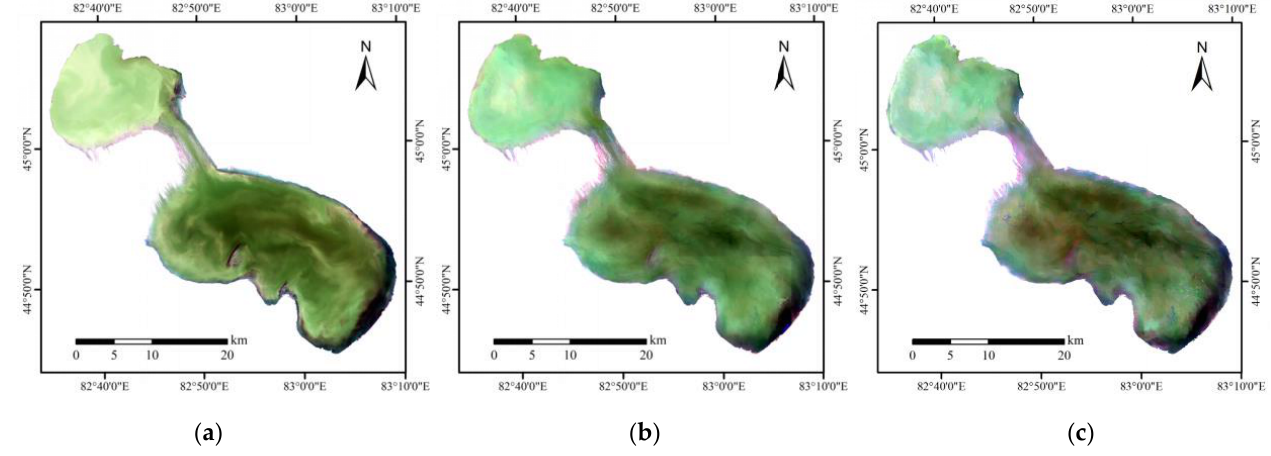
Figure 4. Comparison of the fusion images of ( a ) Landsat 8; ( b ) ESTARFM; and ( c ) FSDAF. Table 3. The evaluation of fusion image accuracy for the ESTARFM and FSDAF models.